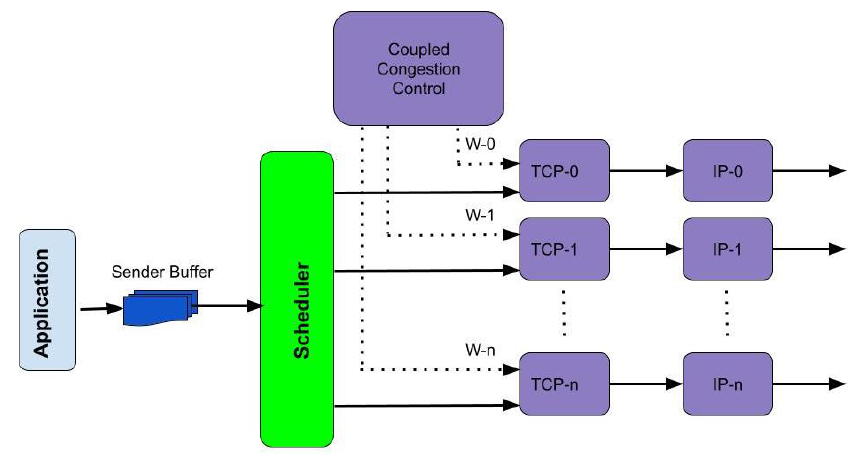
Figure 3. MPTCP packet scheduler coupled with CC.